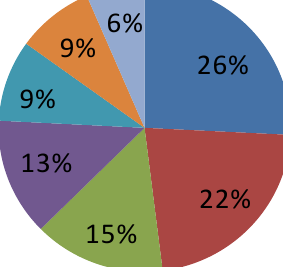
Figure 2. Graphical presentation of the risk factors in metabolic syndrome.